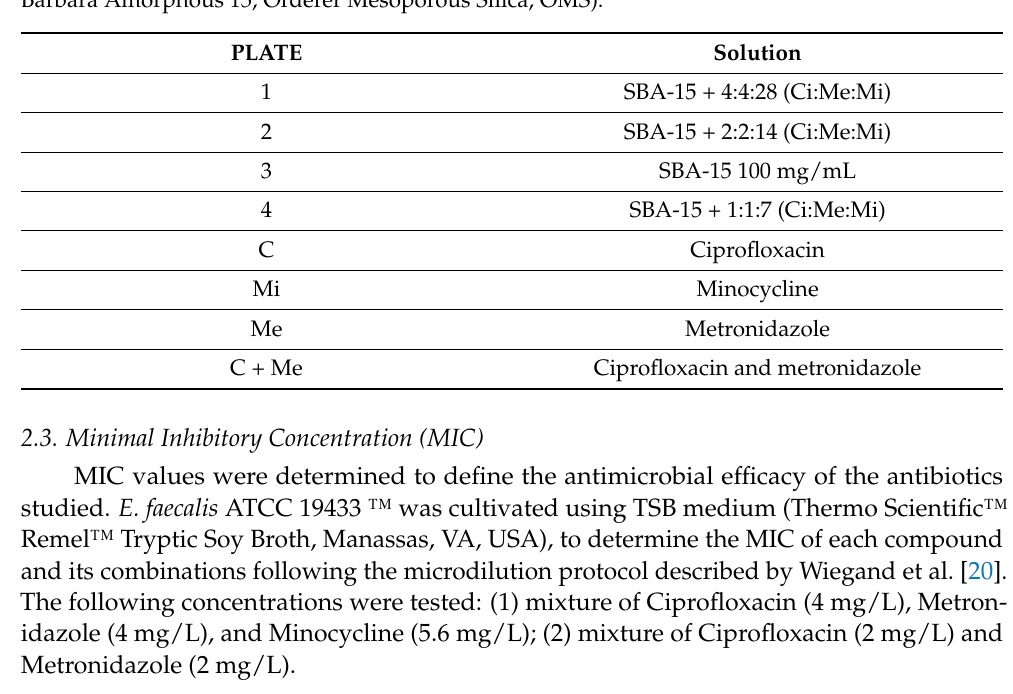
Table 3. Numbering and nomenclature of each plate with its corresponding solution. * SBA-15 (Santa Barbara Amorphous 15, Orderer Mesoporous Silica, OMS).